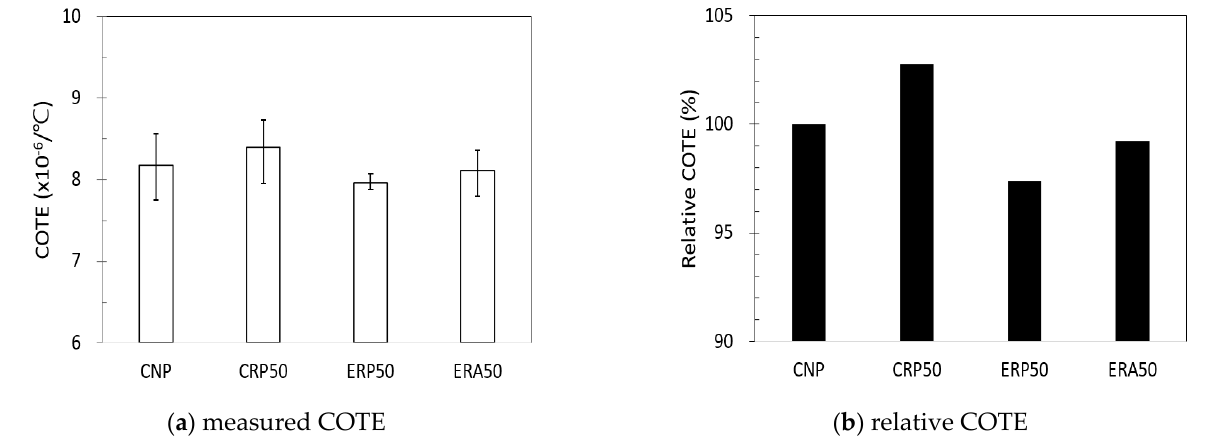
Figure 7. COTE and relative values in test series 3.